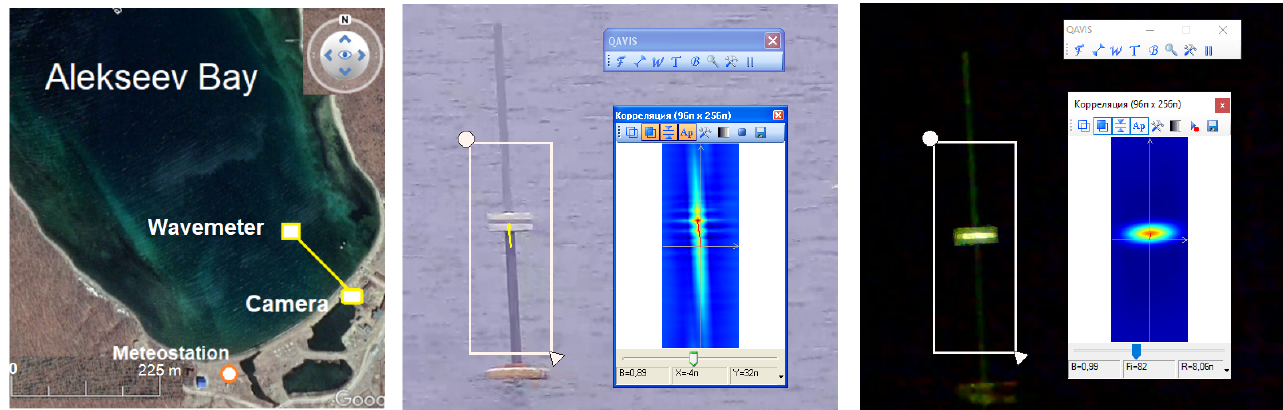
Figure 17. Videowavemeter in Alekseev Bay. Measurement of wave signals in the daytime and at night. Shown from left to right: its location (Google Map used); measuring process of wave signals in the daytime and at night,